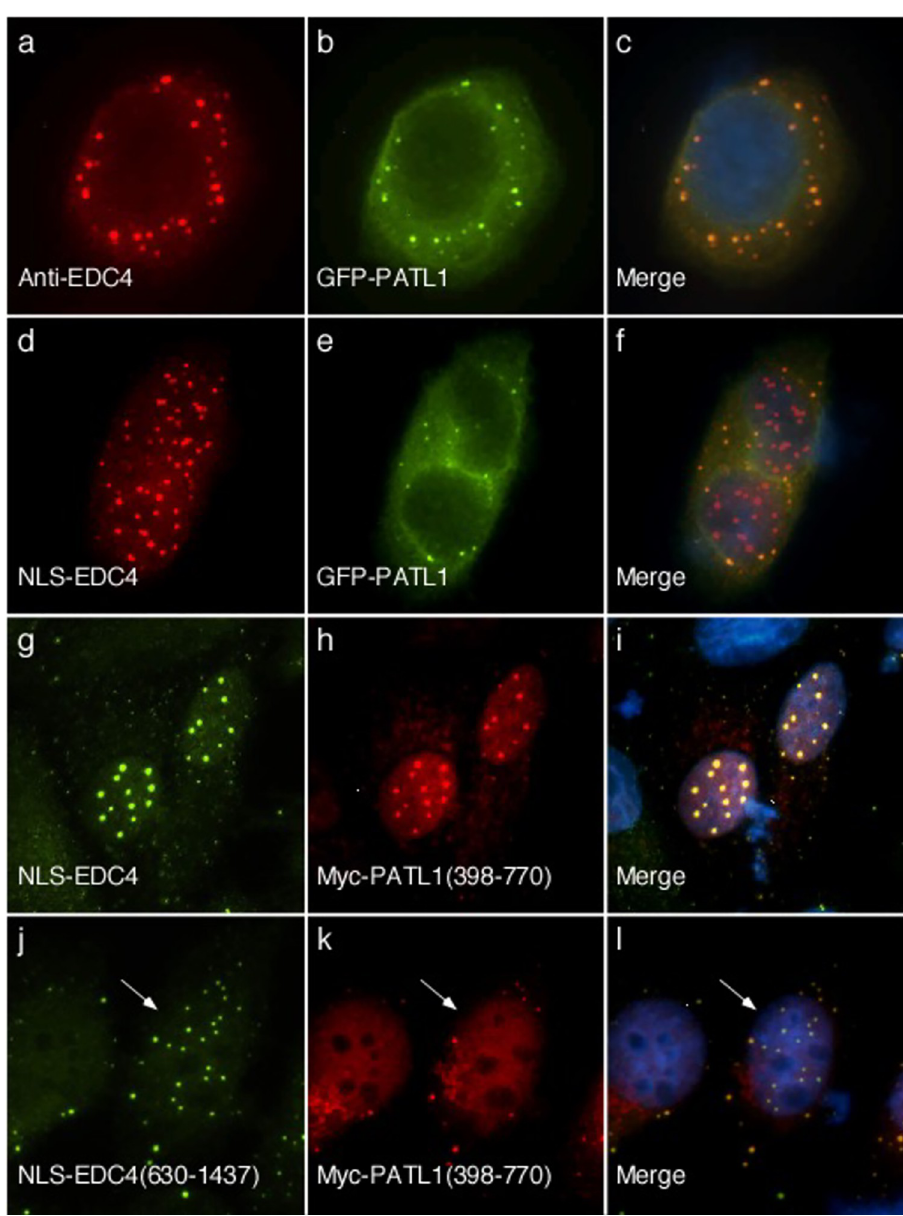
Fig 2. Interaction between PATL1 and EDC4 requires the presence of the C-terminus of PATL1 and the N- terminus of EDC4. After transfection of a plasmid encoding GFP-PATL1 into HEp-2 cells, endogenous EDC4 (panel a) and GFP-PATL1 (panels b, c) localized to cytoplasmic dots. Co-expression of NLS-EDC4 and GFP-PATL1 in HEp- 2 cells resulted in localization of NLS-EDC4 (panel d) in nuclear dots, while GFP-PATL1 remained in cytoplasmic dots (panels e, f). Expression of a plasmid encoding NLS-EDC4 (panel g) together with a plasmid encoding Myc fused to PATL1 amino acids 398–770 (panels h, i) resulted in the two proteins co-localizing in nuclear dots in 97 +/-3% of cells that expressed both proteins. When cells were transfected with GFP-NLS-EDC4(630–1437) (panel j) and Myc-PATL1 (398–770) (panels k, l), GFP-NLS-EDC4(630–1437) localized to nuclear dots while Myc-PATL1(398–770) remained in cytoplasmic dots in all cells that expressed both proteins. Note that the anti-Myc antiserum produces faint diffuse nuclear staining. EDC4 in panels a, d, and g was detected using human serum containing anti-EDC4 antibodies. GFP-PATL1 in panels b and e, and GFP-NLS-EDC4(630–1437) in panel j were detected using mouse monoclonal anti-GFP antibodies. Myc-PATL1 in panels h and k was detected using rabbit anti-Myc antiserum. Merge of panels a and b, d and e, g and h, and j and k is shown in c, f, i and l respectively. DAPI staining (blue) indicates location of nuclei in c, f, i and I. White arrows in j-l indicate a representative cell that contains NLS-EDC4(630–1437) in nuclear dots, while Myc-PATL1(398–770) localized to cytoplasmic